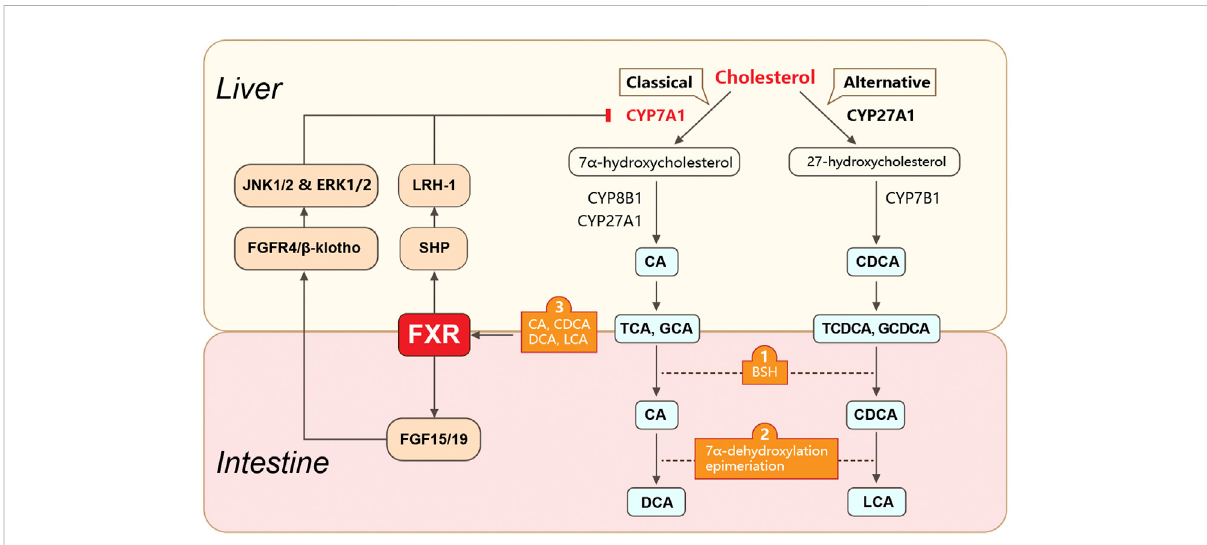
FIGURE 1 Gut microbiota-involved biosynthesis and metabolism of bile acids. Gut microbiota play roles in BA biosynthesis and metabolism. Primary BAs are synthesizedinhepatocytes from cholesterol via classical or alternative pathways.They are furtherconjugated with taurine (in mice)or glycine (in humans) and transformed into conjugated BAs (e.g., TCA, GCA, TCDCA, and GCDCA). The conjugated primary BAs are secreted from the liver into thebileandsubsequentlyintotheintestinallumen,wheretheyareunconjugatedbybacteria-producedBSH.TheunconjugatedprimaryBAsare biotransformed into secondary BAs (e.g., DCA, UDCA, and LCA) via 7 α -dehydroxylation or epimerization. The gut microbiota also mediates the enterohepatic circulation of BAs via FXR. FXR is activated by unconjugated BAs (e.g., CDCA, DCA, LCA, and CA) and regulates BA synthesis via molecules in the liver and intestine. In the liver, FXR suppresses the expression of CYP7A1 (the rate-limiting enzyme for the classical pathway of BA synthesis)byactivatingSHP.SHPfurtherbindstoLRH1.Intheintestine,FXRsuppressesCYP7A1expressionbyupregulatingFGF15(FGF19inhumans) expression. FGF15 further binds to the FGFR4/ β -klotho complex and induces JNK1/2 and ERK1/2 signaling. BAs, bile acids; TCA, taurocholic acid; GCA, glycocholic acid; TCDCA, taurochenodeoxycholic acid; GCDCA, glycochenodeoxycholic acid; BSH, bile salt hydrolase; DCA, deoxycholic acid; UDCA, ursodeoxycholic acid;LCA, lithocholicacid; FXR, farnesoid Xreceptor;SHP, smallheterodimerpartner; LRH1, liverreceptor homolog 1; FGF15, fi broblast growth factor 15; FGFR4, FGF receptor